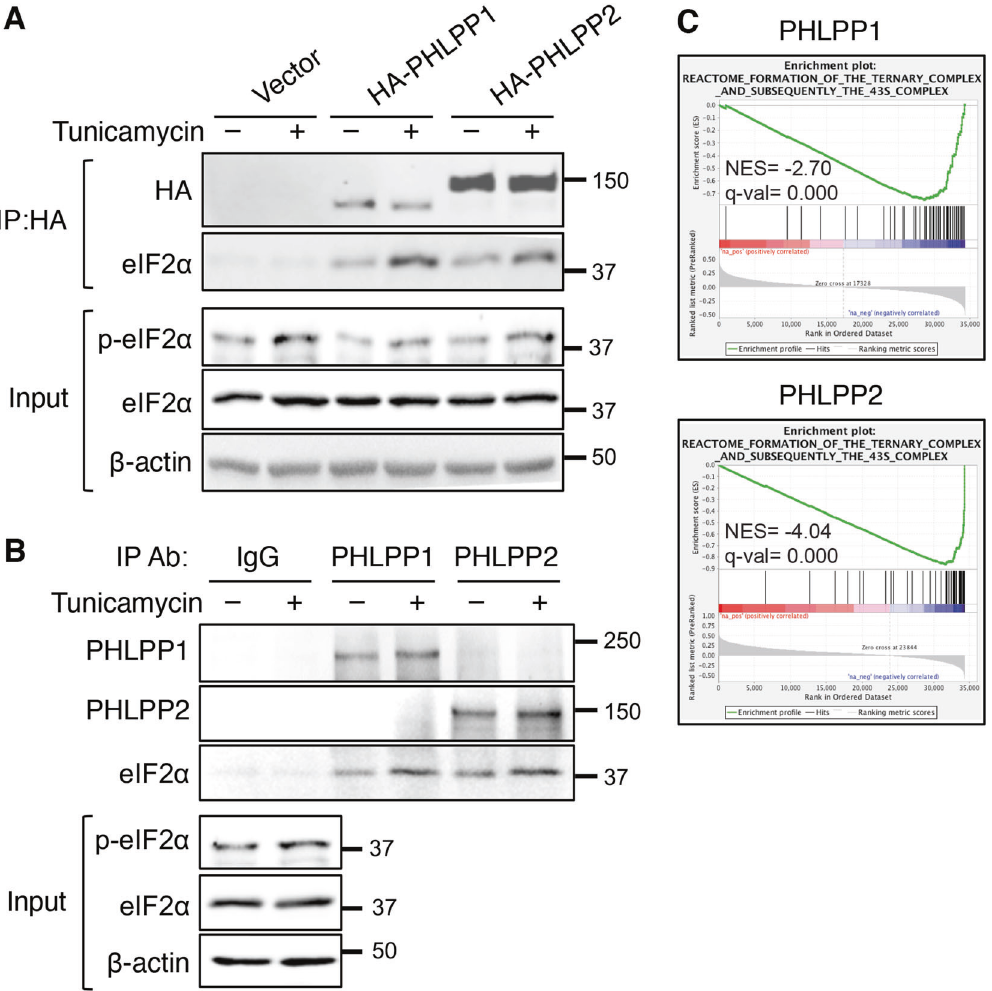
immunoprecipitates was detected using the HA or eIF2 α antibodies, respectively. The levels of p-eIF2 α and total eIF2 α in the input were analyzed using Western blot. b SW480 cells were treated with DMSO or tunicamycin for 3 h. Cell lysates were immunoprecipitated using